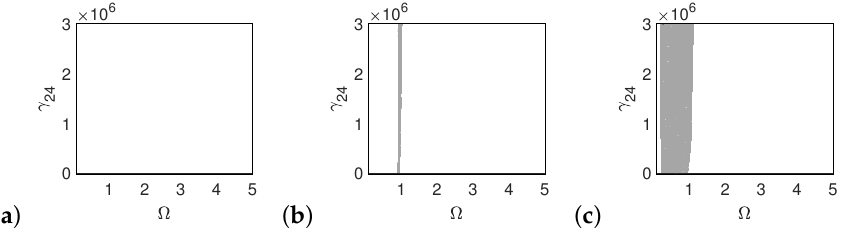
Figure 9. Regions of polyharmonic vibrations of the magnet for the case of the normal ear versus the nonlinear stiffness rate of the coupler ( γ 24 ) and the excitation frequency ( Ω ) under the excitations p ( a ), 5 p ( b ) and 10 p ( c